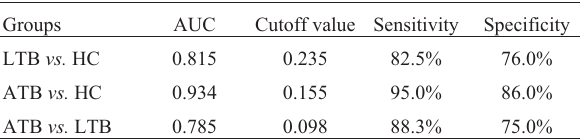
Figure 2C, a ROC curve with an AUC value of 0.785 was ob- tained with a sensitivity and specificity of 88.3% and 75.0%, respectively, at a cutoff value of 0.098 (Table 2), indicating a moderate diagnostic value of miR-145.